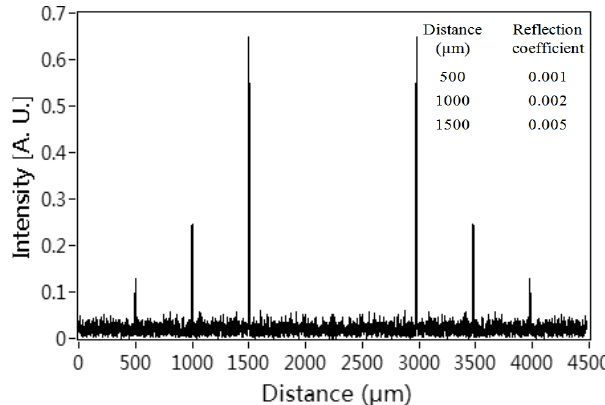
Fig. 9. The simulation result of sample 1 by the SD-OCT A-scan